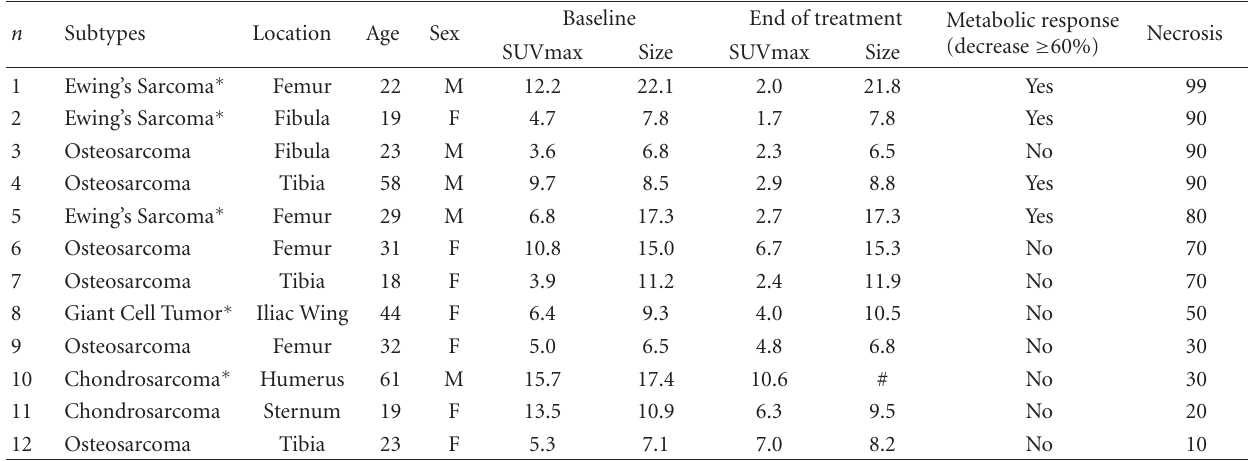
Figure 3: (a) SUVmax values (numerical) and changes in SUVmax (bars) after completion of neoadjuvant treatment for each patient. (b) depicts changes in tumor size from baseline to end of treatment. Histopathologic responders are illustrated in orange. Three of four histopathologic responders showed decreases in SUVmax by ≥ 60% from baseline to followup scan. One histopathologic responder with a 38% decrease in FDG uptake from baseline to followup showed an SUVmax value after completion of neoadjuvant therapy of < 2.5 and was therefore correctly classified. Size changes in response to treatment were marginal. Table 1: Patient characteristics and imaging